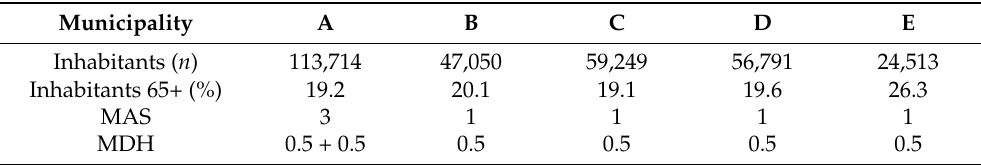
Table 1. Characteristics of the five municipalities that participated in the intervention: the numbers of inhabitants, percentage of inhabitants 65+, and number of MASs (=Local head nurses) and MDHs (=Municipal dental